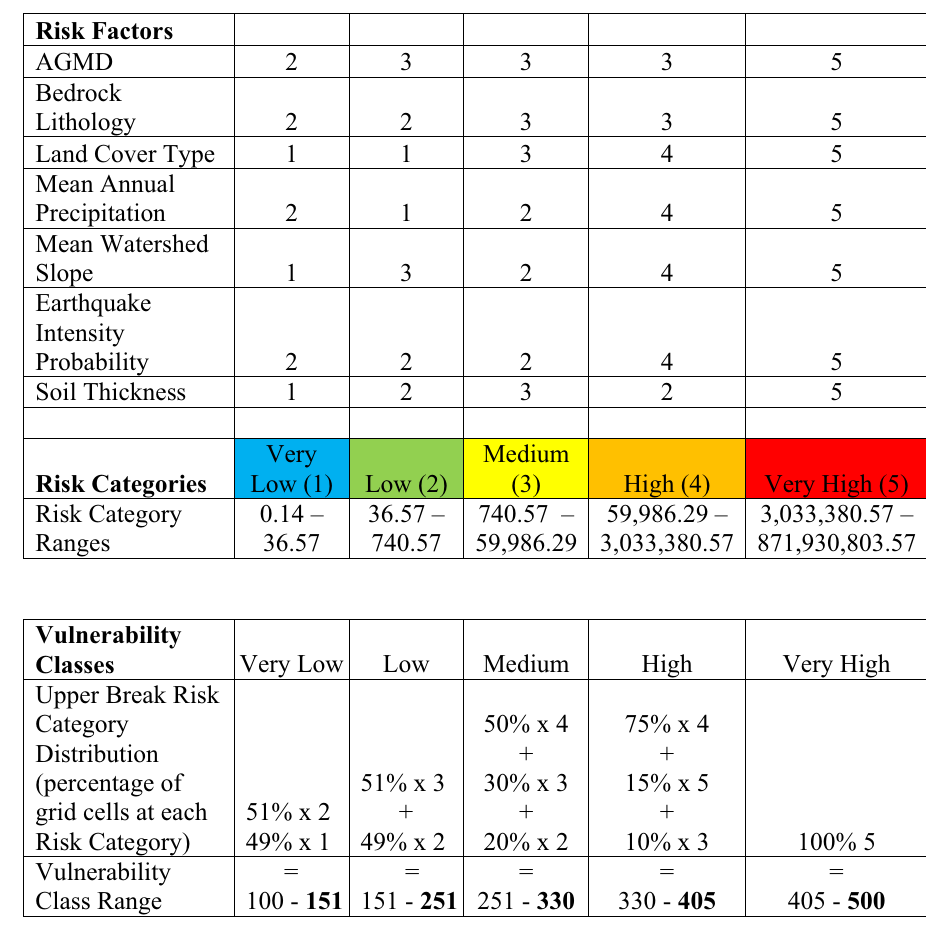
Table 2. Risk Factor (RF) distribution in Risk Categories for the tropical Erosion Vulnerability Index (EVI) and Vulnerability Classes for watershed EVI and Erosion and Deposition Index